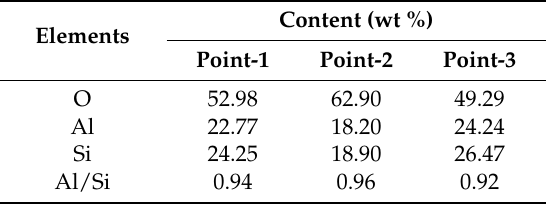
Table 2. EDS analysis of raw coal gangue.